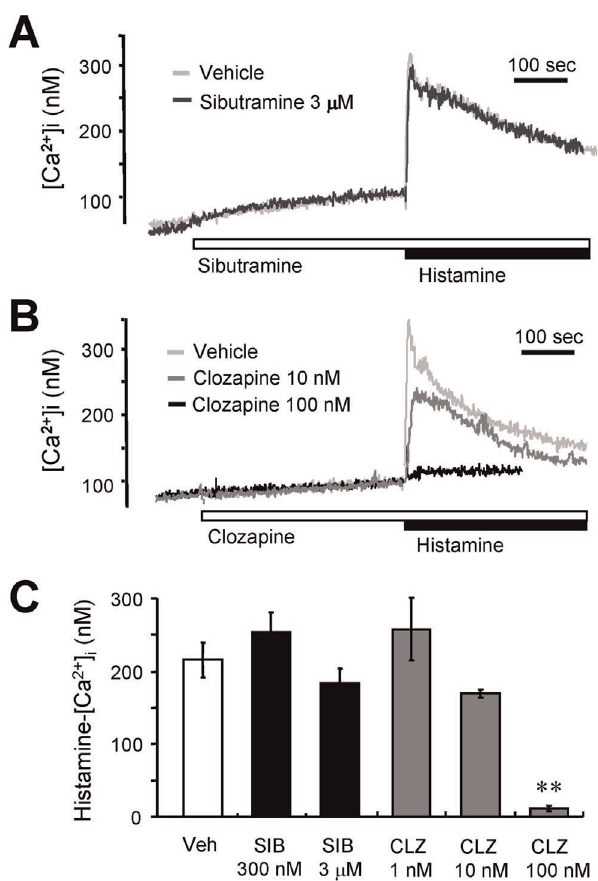
Figure 5. Clozapine, but not sibutramine, inhibits histamine- induced [Ca 2 + ]i rise in GT1-1 cells. (A) Fura-2-loaded GT1-1 cells were challenged with 100 m M histamine in the absence (gray trace) or presence (black trace) of 30 m M sibutramine. Typical [Ca 2 + ]i traces from more than seven separate experiments are presented. (B) Cells were challenged with 100 m M histamine in the absence (light gray trace) or presence of 10 nM (gray trace) or 100 nM (black trace) clozapine. Typical [Ca 2 + ]i traces from more than three separate experiments are presented. (C) Cells were treated with indicated concentrations of sibutramine (SIB) or clozapine (CLZ) before challenging with 100 m M histamine. The net increases in histamine-induced [Ca 2 + ]i are expressed by mean 6 SEM. The experiment was independently performed three times. **P , 0.01, compared to the response with histamine only (Veh). All results were reproducible.